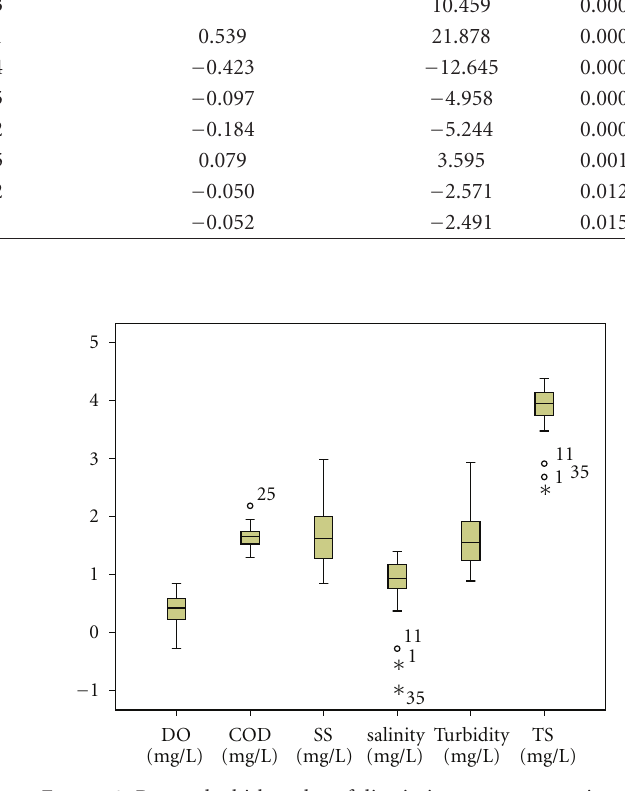
Figure 3: Box and whisker plot of discriminant parameters in wet season (backward